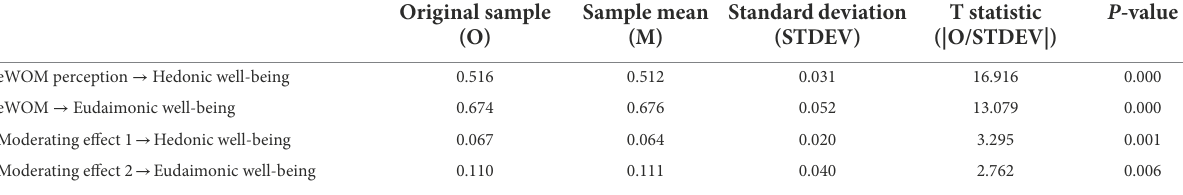
TABLE 7 Study 2: Path coefficients under moderating effect (social environment).